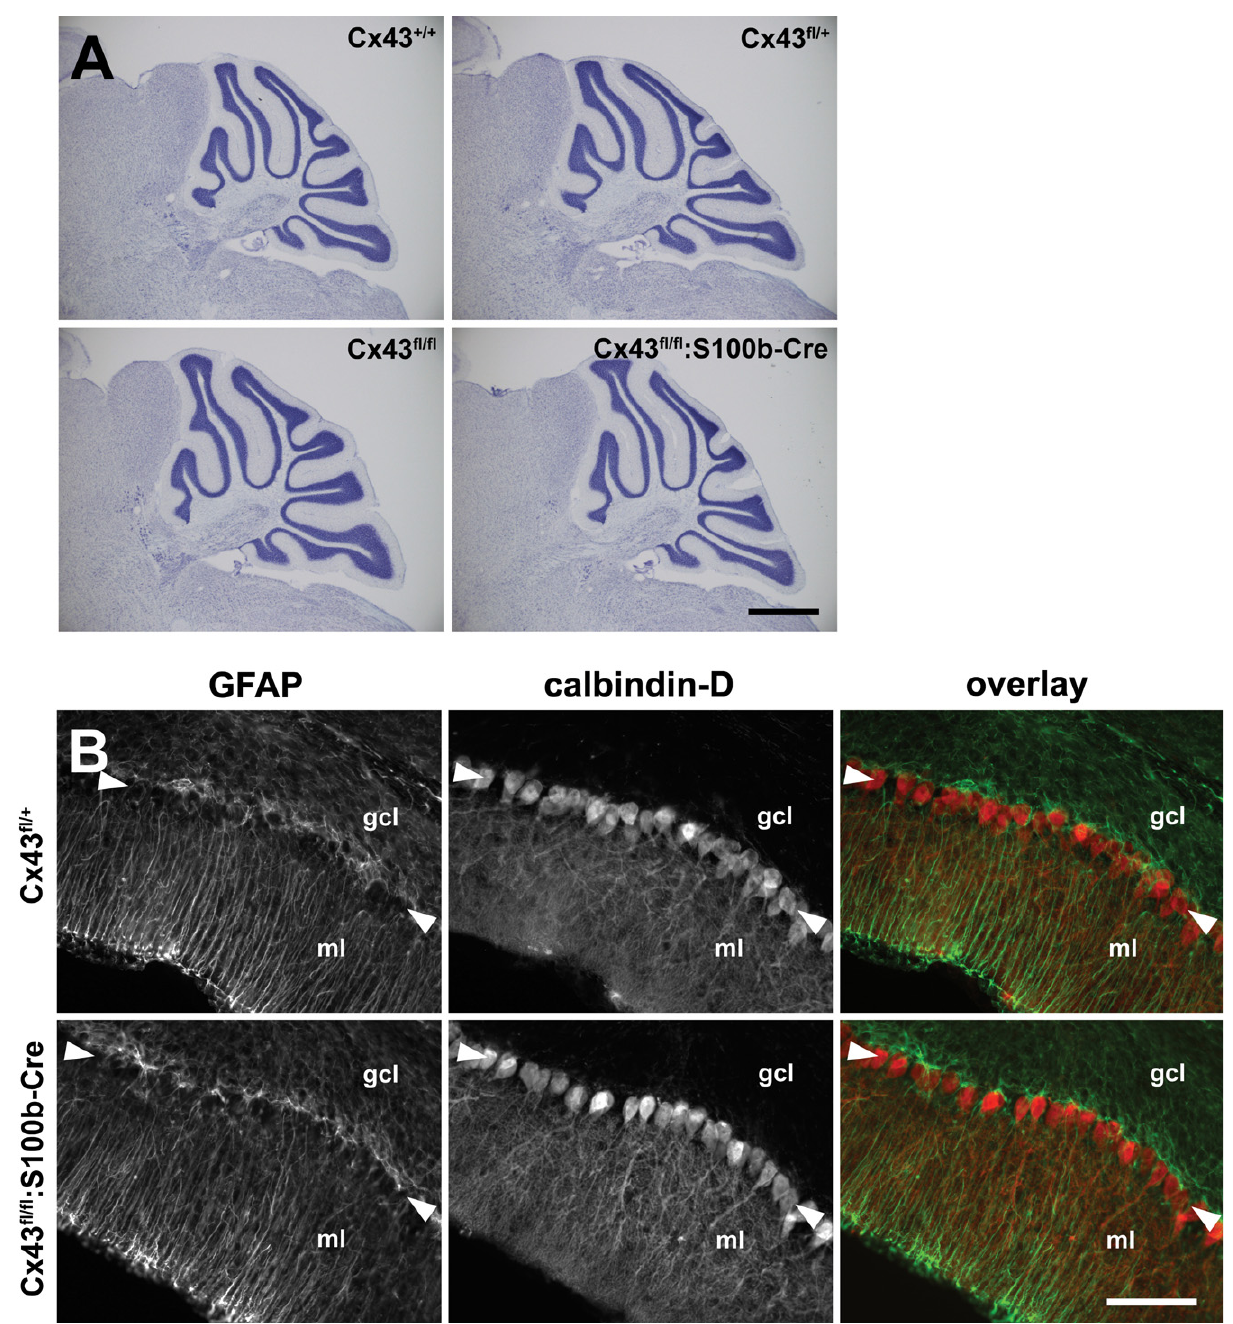
Figure 7. Histologic analysis of Cx43 fl /fl :S100b-Cre cerebellum. (A) Nissl-stained parasagittal sections of the cerebellum from Cx43 + / + (WT), CX43 fl / + , Cx43 fl /fl , and Cx43 fl /fl :S100b-Cre mice (2.5 month old). There were no gross morphologic differences among genotypes. Scale bar, 1 mm. (B) Double immun- ofl uorescence analysis for GFAP (green) and calbindin-D (red) of parasagittal sections of the cerebellum from Cx43 fl / + and Cx43 fl /fl :S100b-Cre mice (1.5 month old). Arrowheads indicate Purkinje cell layer. gcl, granule cell layer; ml, molecular layer. Scale bars, 100